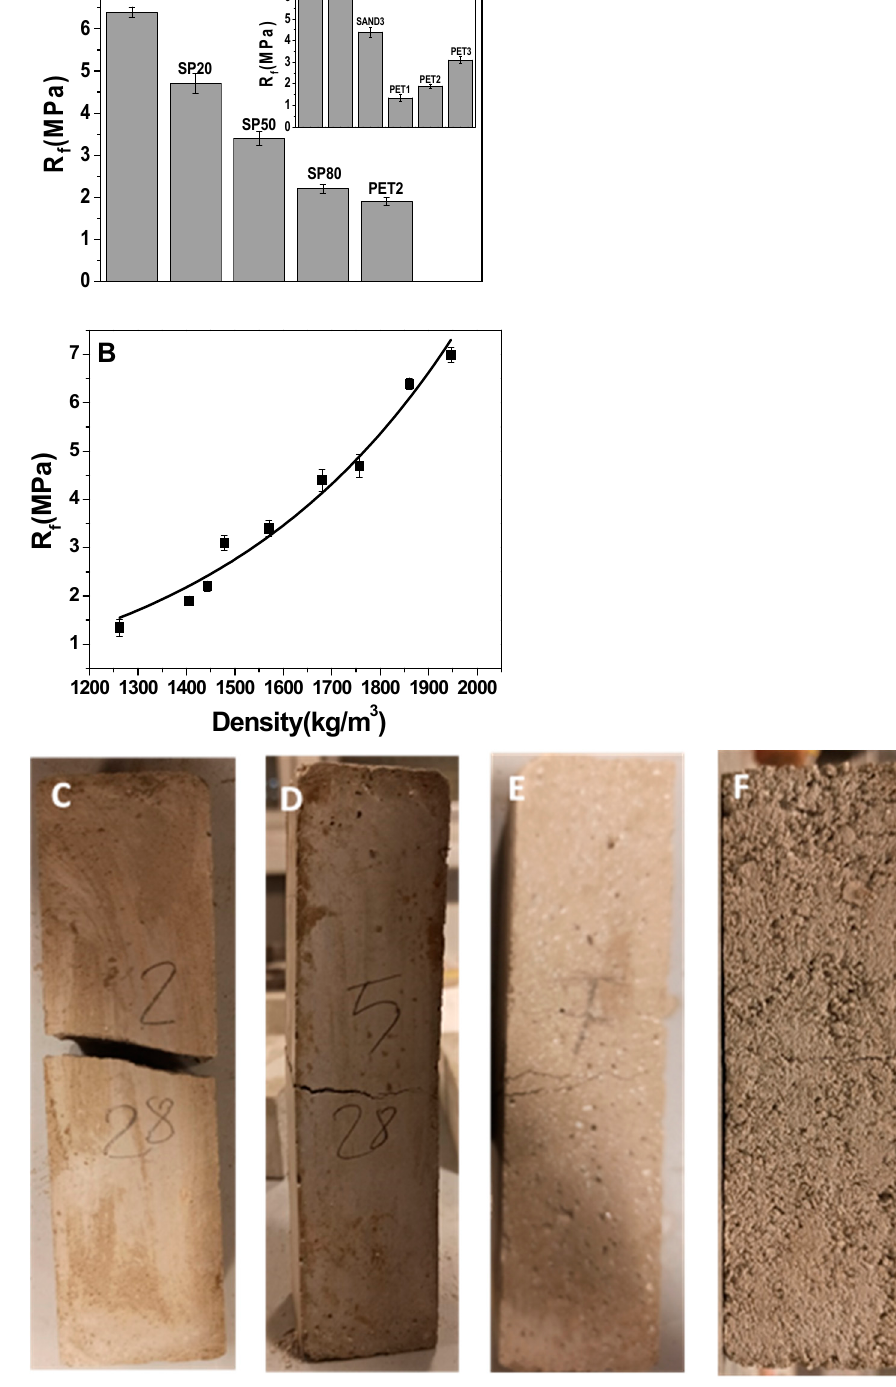
Figure 3. ( A ) Flexural strengths of SAND2, SP and PET2 samples (with 500 g of aggregate). In the inset: flexural strengths of bare SAND and PET specimens. ( B ) Exponential increase in the flexural strengths with density. Flexural cracks in ( C ) SAND1 sample, ( D ) SP50 sample, ( E ) PET2 sample, ( F ) PET1 sample.